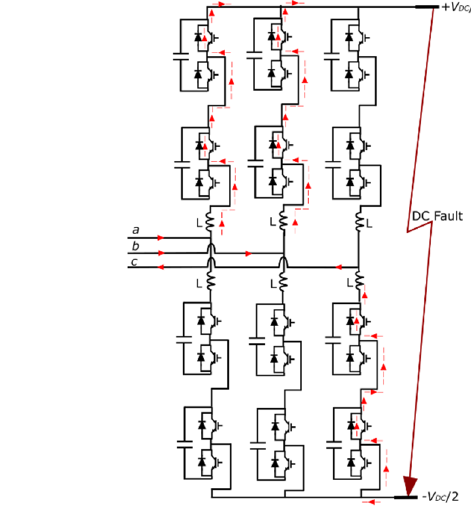
Figure 3. Fault current path: ( a ) FBSM for i sm > 0; ( b ) FBSM for i sm < 0. A DC side fault event in MMCs can be divided into three stages [43–46]. In the first stage, the MMC is still able to generate the AC side voltages and therefore the AC side currents remain controlled. So, the fault current in this first stage consists mainly of a DC component due to the discharge of the SM capacitors. The discharge of the capacitors means that the MMC can no longer generate the AC side voltages and starts to lose control of the AC side currents. So, in the second stage, the AC side starts contributing to the fault. Thus, there is an AC component in the fault current in addition to the DC component. In the third stage, all IGBT switches in the SMs are blocked, which prevents the further dis- charge of capacitors. However, depending on the type of SM used, the AC side may still feed the DC side fault [47] due to the freewheeling diodes in the SMs. The fault stages 1 and 3 are illustrated in Figure 4; stage 2 is omitted since it is merely a combination of stages 1 and 3.